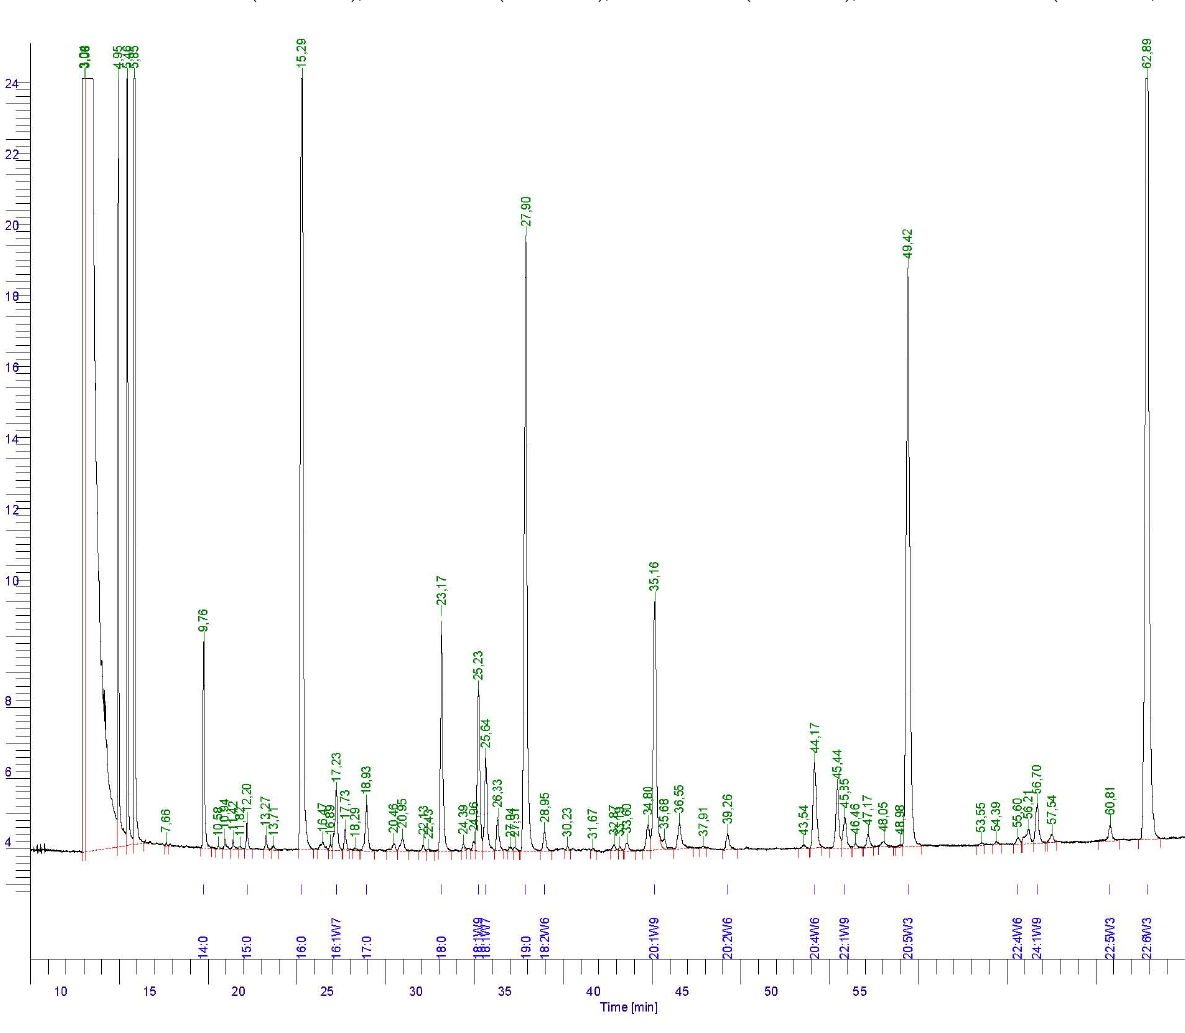
Figure 2. Fatty acid (FA) profile of initial by-products. Retention time (min) of individual FA is indicated in green. Assignation of peaks is expressed in blue.